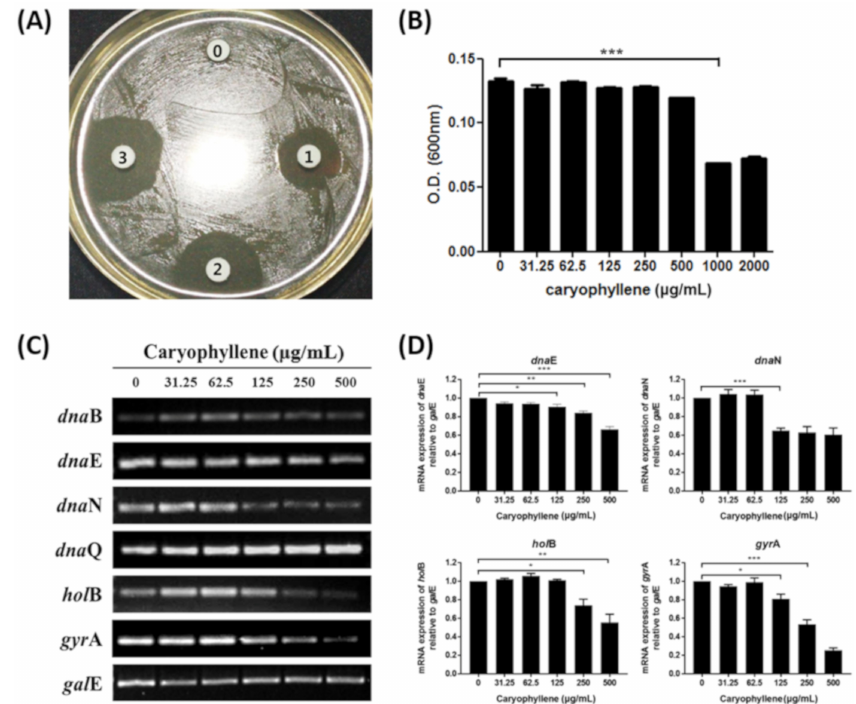
Figure 1. Anti-bacterial activity of β -caryophyllene against H. pylori and downregulation of replication-related genes of H. pylori . ( A ) Growth inhibitory activity of β -caryophyllene against H. pylori was confirmed by a disc diffusion test. Disk 0, control; disk 1, β -caryophyllene 10 µ g; disk 2, β -caryophyllene 50 µ g; and disk 3, β -caryophyllene 100 µ g. ( B ) Minimal inhibitory concentration of β -caryophyllene against H. pylori was determined by the broth dilution method. Results from triplicate experiments were analyzed by Student’s t -test (** p < 0.001). ( C ) The mRNA level expression levels of DNA replication machineries. Constitutively expressed gal E was used as an internal control. ( D ) Density of the bands were illustrated as a graph and the results from triplicate experiments were analyzed by Student’s t -test (* p < 0.05, ** p < 0.01 and *** p <